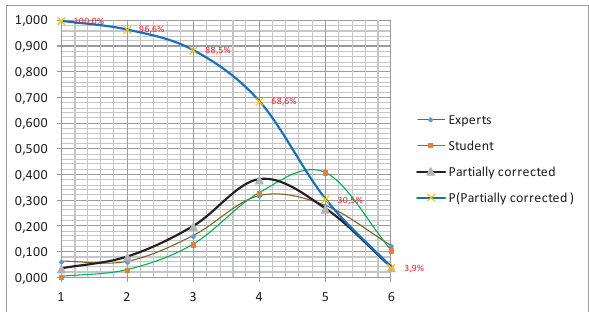
Figure 6. Collective work